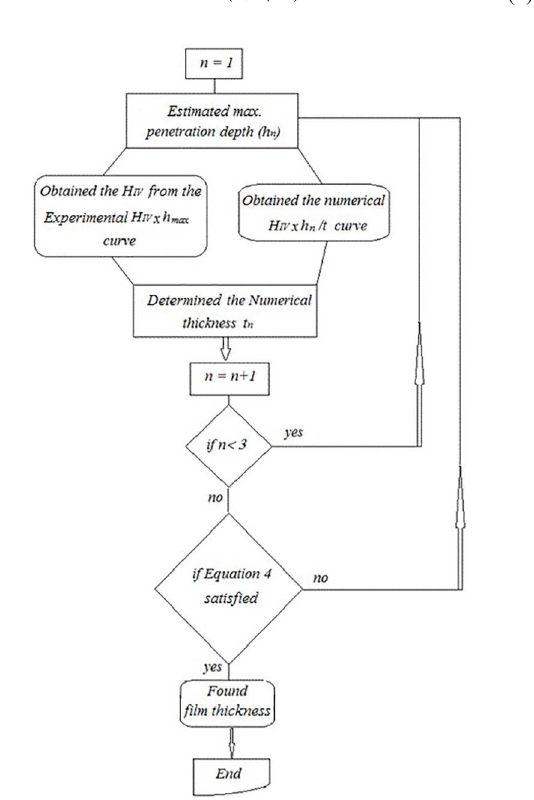
Figure 4. The flowchart used to combine numerical and experimental indentation procedures to determine TiN film